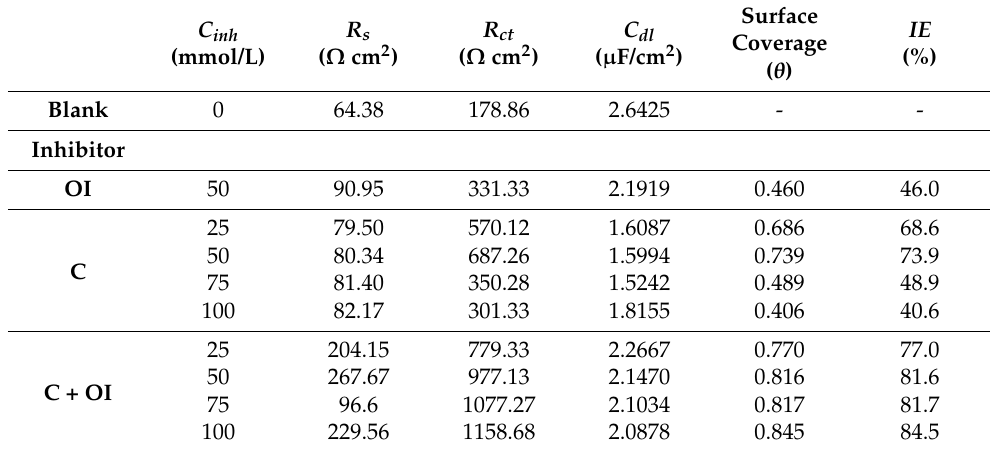
Table 4. EIS results for C, OI and C + OI in 0.1 M NaCl. The values of R S and R ct are given in Ω cm 2